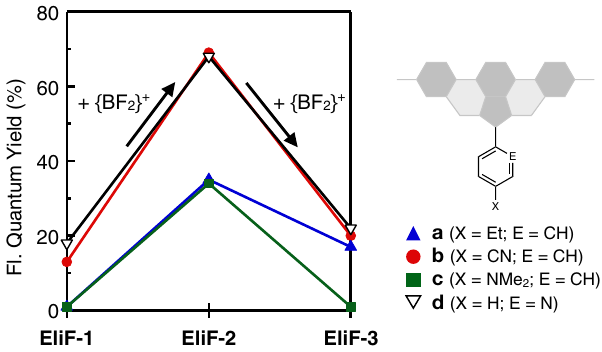
Fig. 3 | Structure-dependent light-emitting properties. Changes in the fl uores- cence emission quantum yield ( Φ F ) of EliF-a (blue line), EliF-b (red line), EliF-c (green line), and EliF-d (black line) series molecules in CHCl 3 ( T =293K; λ exc = 350nm) with progressive installation of {BF 2 } + fragments onto the [ N , N ]-bidentate pocket. Fl fl